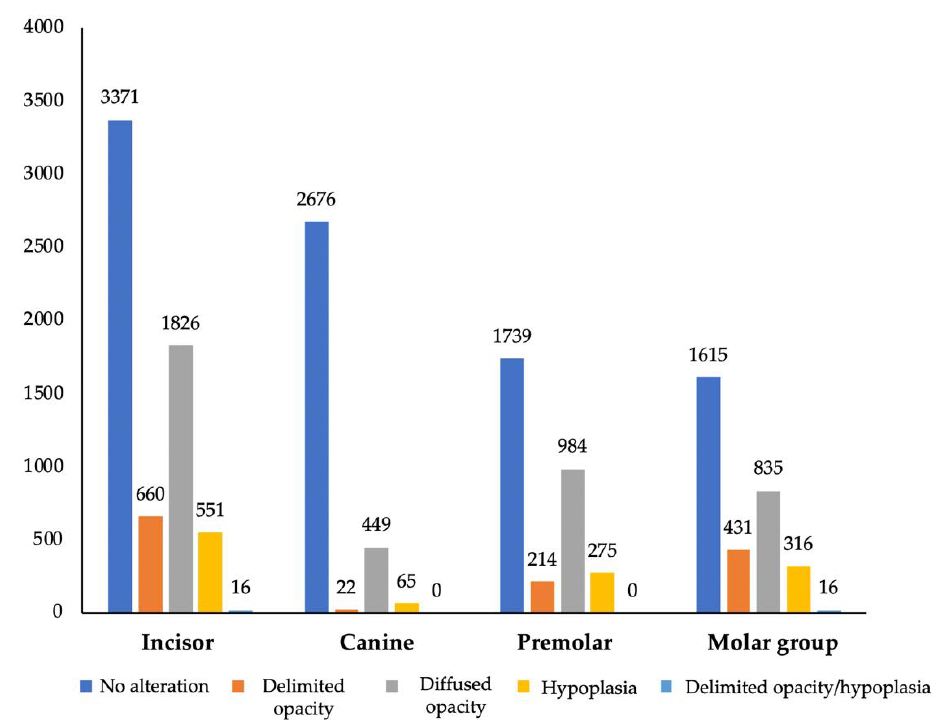
Figure 1. Distribution of types of DDEs by dental group.